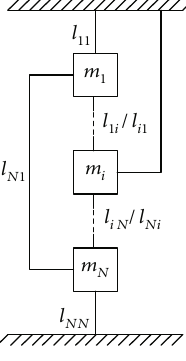
Figure 5: Link model of the N -degree-of-freedom